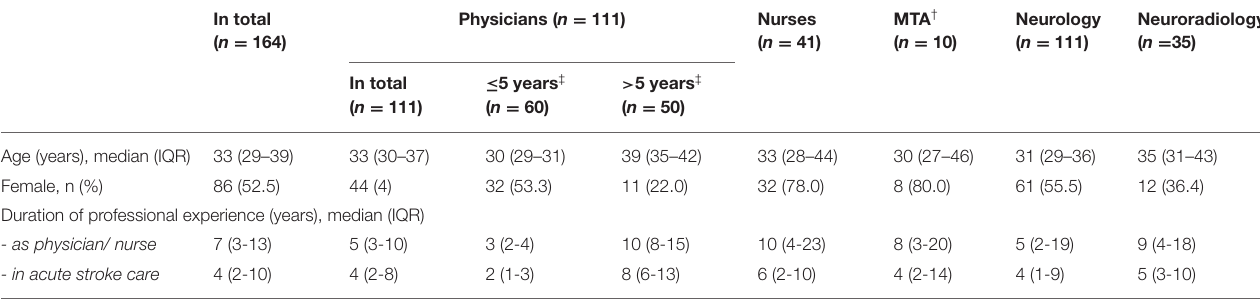
TABLE 2 | Participant characteristics.